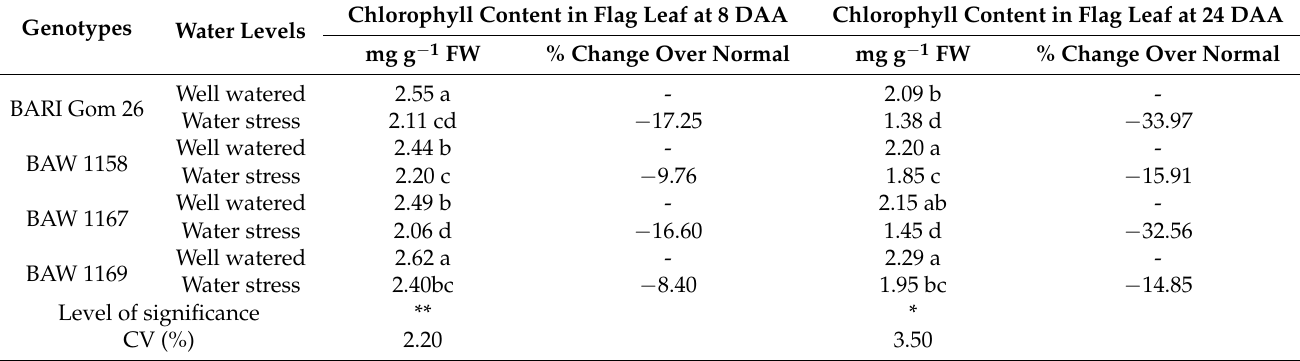
Table 7. Effect of DS on the flag leaf chlorophyll content of different wheat genotypes at 8 and 24 DAA.